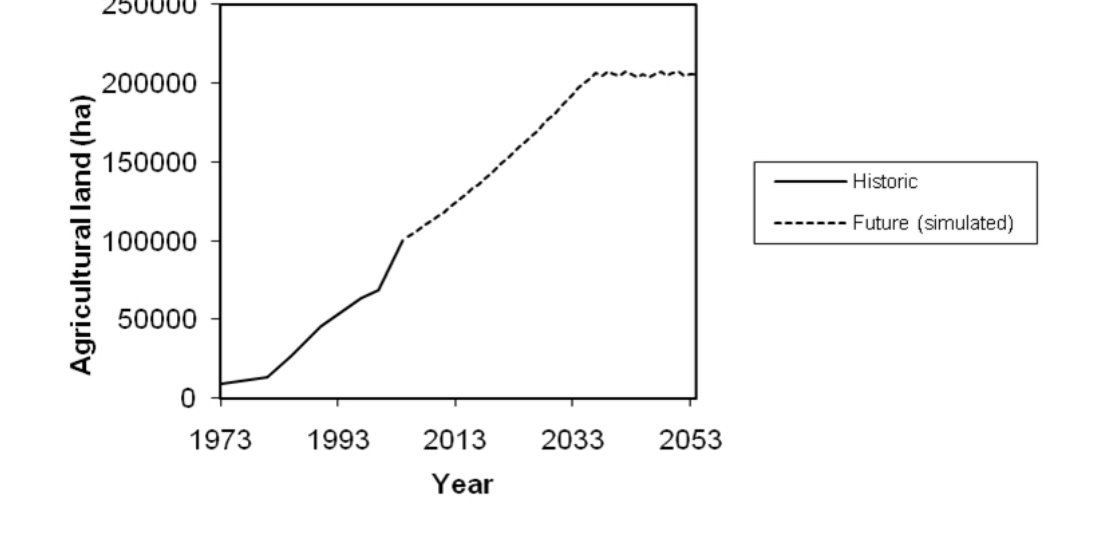
Fig. 6 . Growth in agricultural land in the Cuenca according to historical data and the conventional scenario